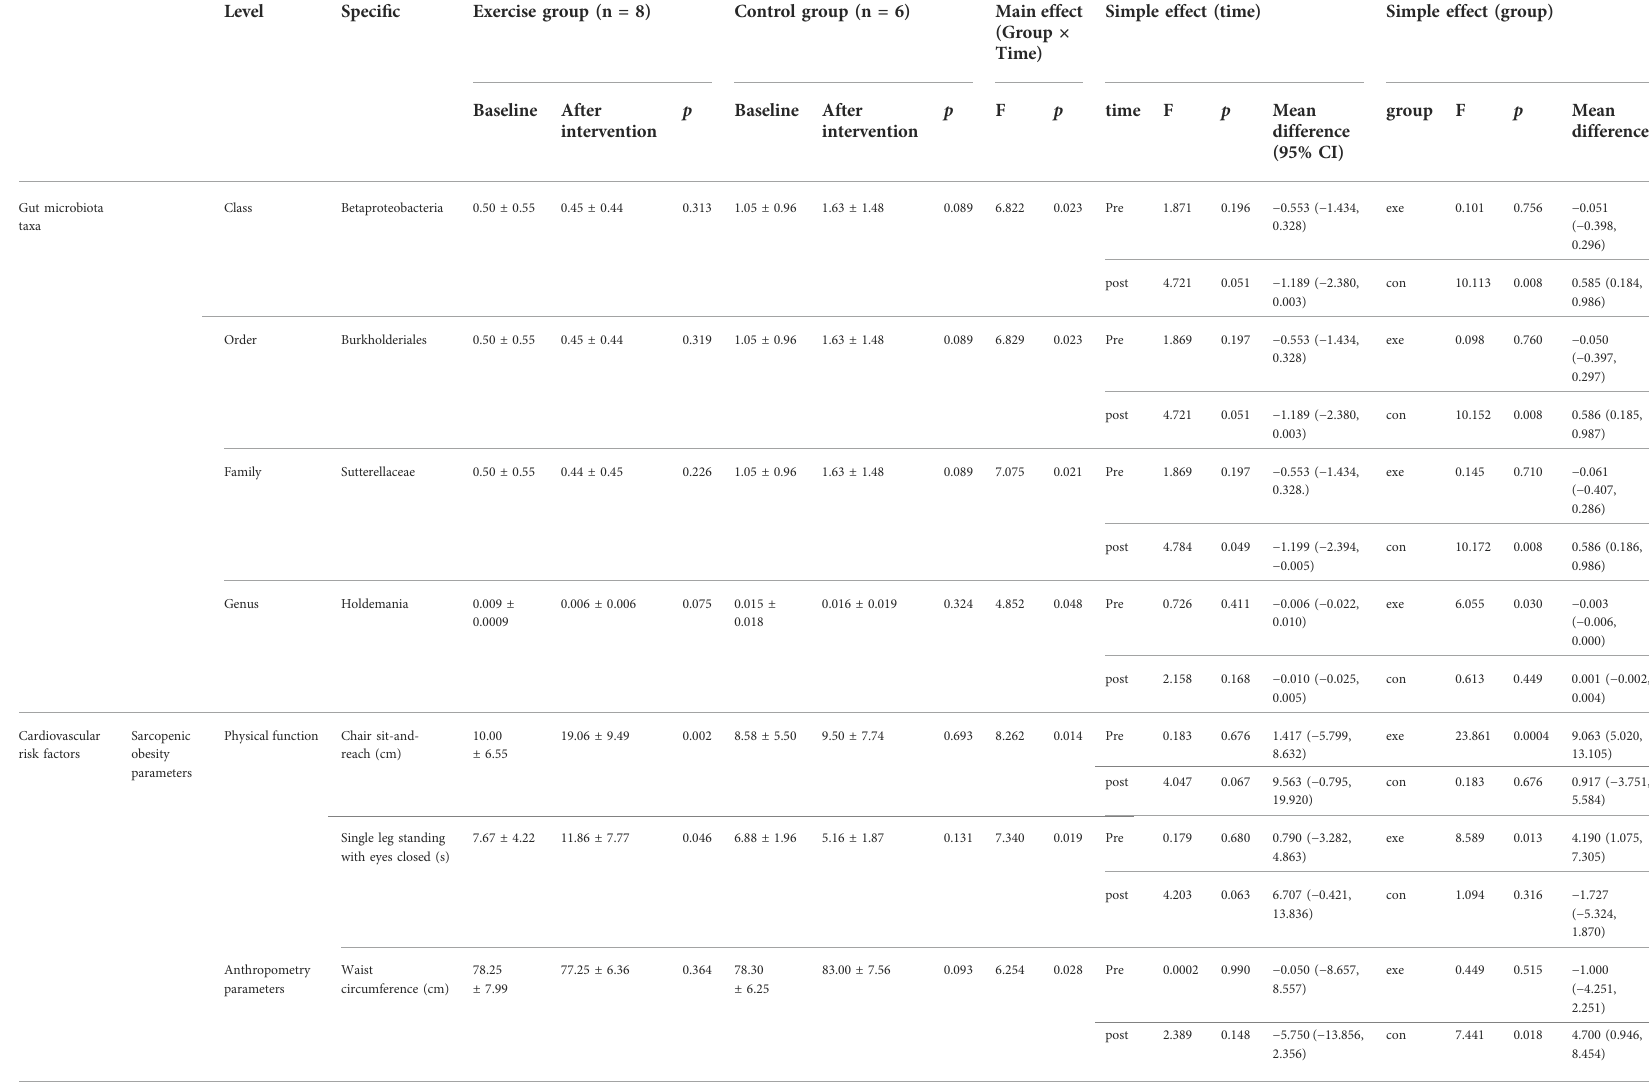
TABLE 2 Changes in gut microbiota and cardiovascular risk factors in each group following the